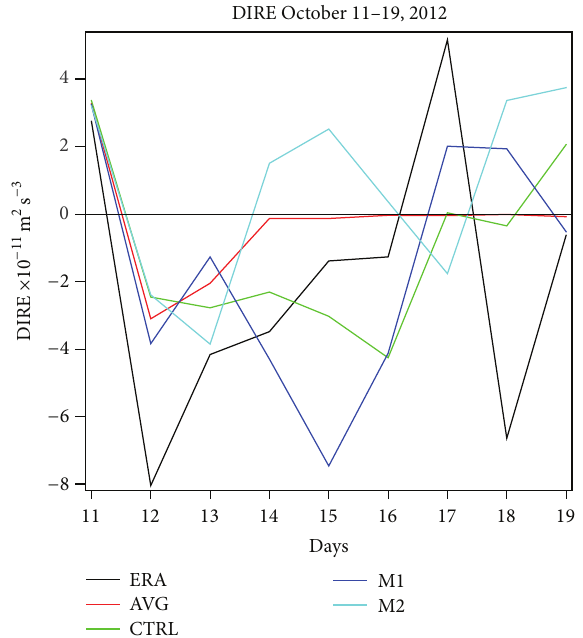
Figure 6: ERA and GEFS values of DIRE for October 11–19, 2012. Shown are ERA reanalysis (black), GEFS ensemble mean (red), GEFS control (green), and two other ensemble members (dark and light blue).